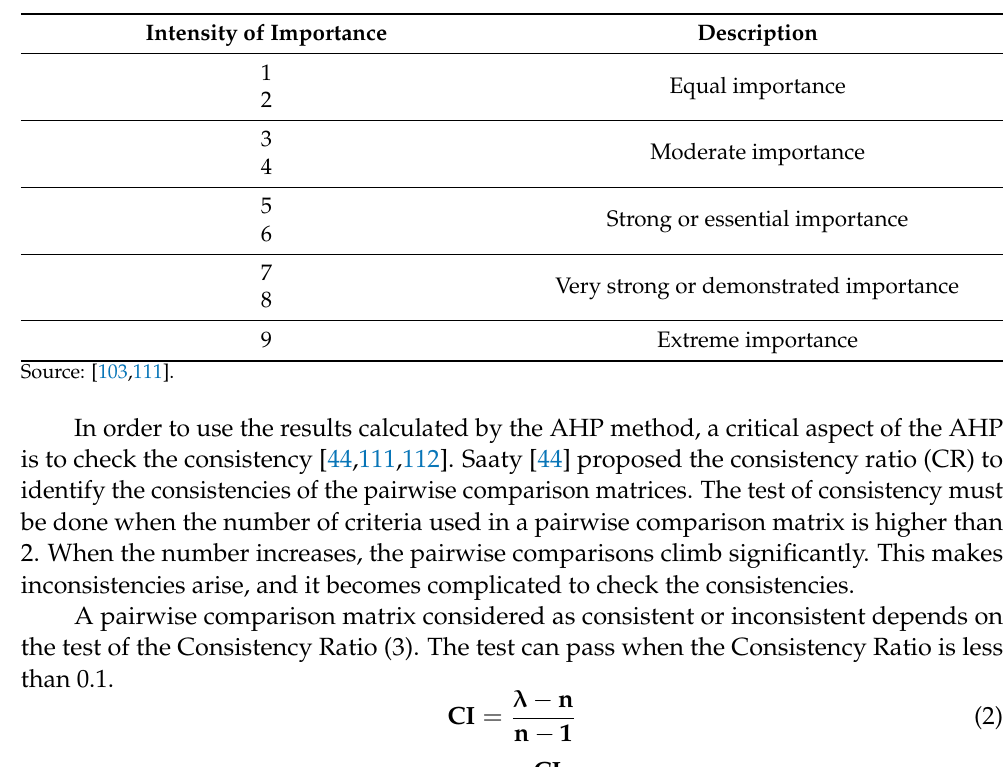
Table 1. Scale for pair-wise AHP comparisons.